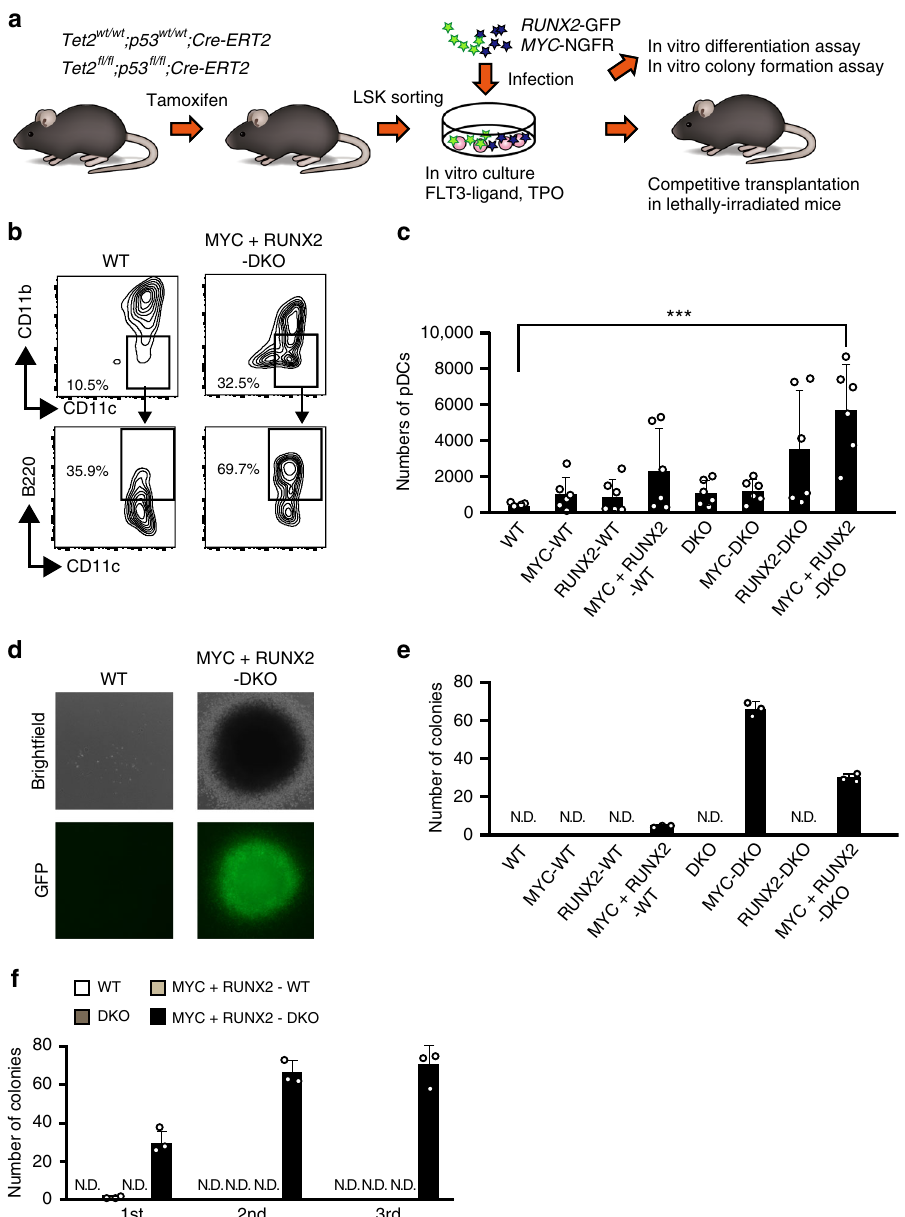
Fig. 6 Transduction of MYC and RUNX2 promote the production of pDCs with the serial replating property. a Experimental scheme utilizing MYC and RUNX2 vectors and Tet2/p53 DKO mice for in vitro and in vivo assays. b Representative fl ow cytometric pro fi les of the CD45 + CD11b − -gated CD11c + B220 + cells. c Absolute numbers of CD11b − CD11c + B220 + pDCs among 1000 LSK cells-derived CD45 + hematopoietic cells under liquid culture conditions ( n = 6). d Representative colony images (top columns) and GFP (bottom columns) of WT and DKO cells expressing MYC plus RUNX2 in the fi rst plating. e Increased colony-forming properties of DKO cells expressing MYC and DKO cells expressing MYC plus RUNX2 ( n = 3). f Enhanced serial re-plating properties of DKO cells expressing MYC plus RUNX2 (black bars) from those of WT cells (opened bars), WT cells expressing MYC plus RUNX2 (gray bars) and DKO (dark gray bars) ( n = 3). c , e , f Bars show the mean±SD, * p < 0.05 and ** p < 0.01 by the Student ’ s t -test. N.D. not detected. Data